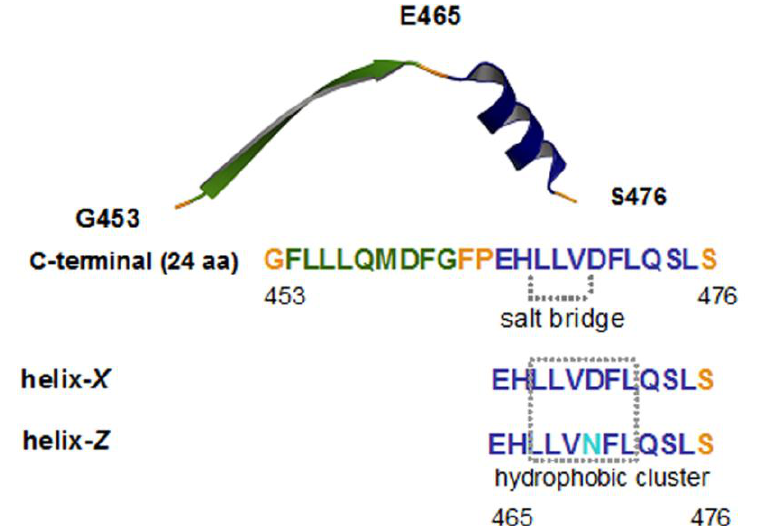
Figure 1. Structural representation of the C -terminal region of cholesteryl-ester transfer protein (CETP), showing the sequences of helix- X and helix- Z . The H and the hydrophobic cluster are shown. The structure was obtained from the Protein Data Bank, access code: